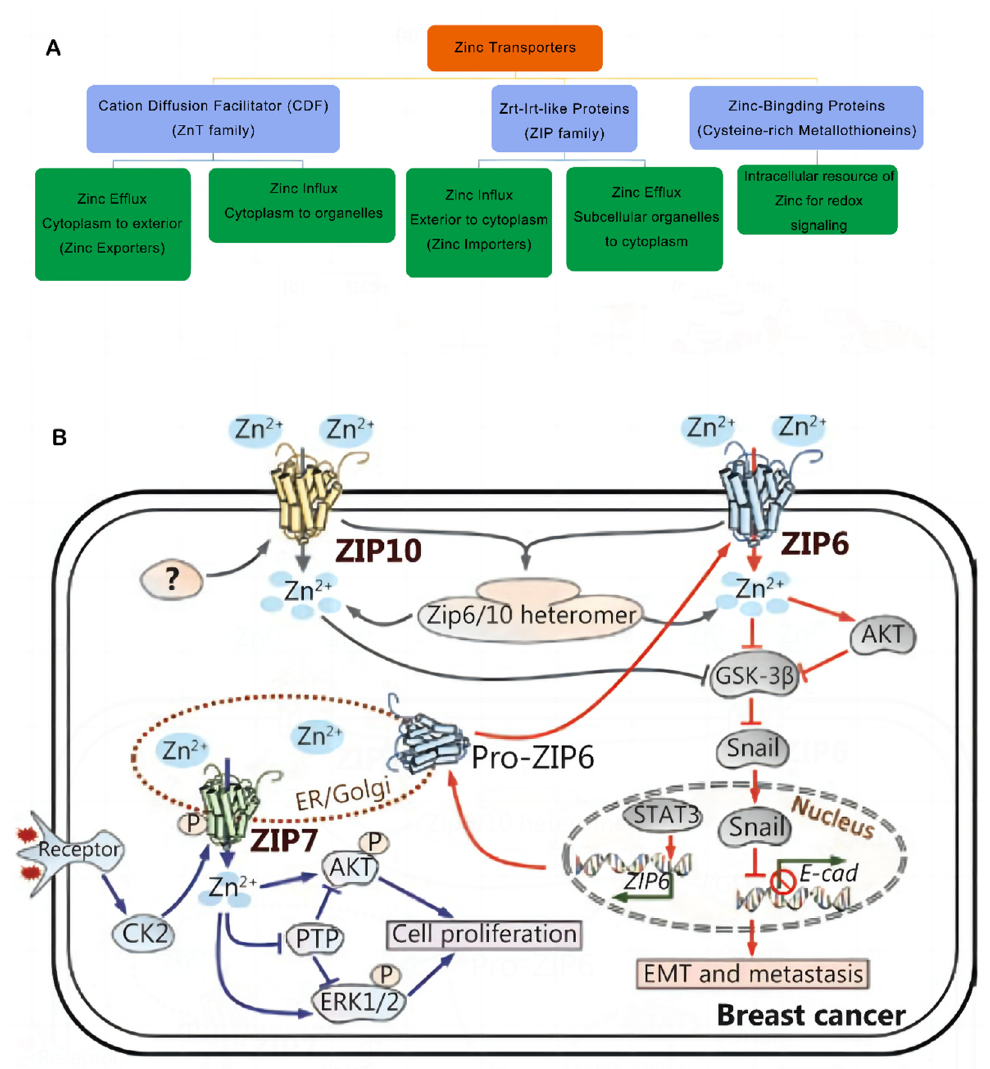
Figure 1. ( A ) Classification of zinc transporters and their functions. Abbreviations: ZIP, Zrt-Irt-like protein; ZnT, zinc transporter. ( B ) Zinc signaling pathways in breast cancer. The transporter-mediated imbalance of intracellular zinc can contribute to the development and progression of breast cancer. Reproduced with permission [26]. Copyright © 2022 Wiley Periodicals LLC.